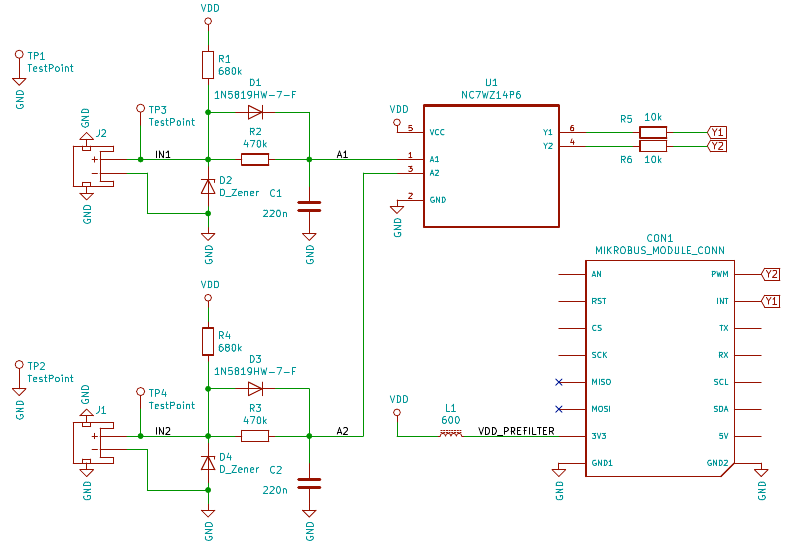
Figure 7. Scheme of data reading module from the selected water